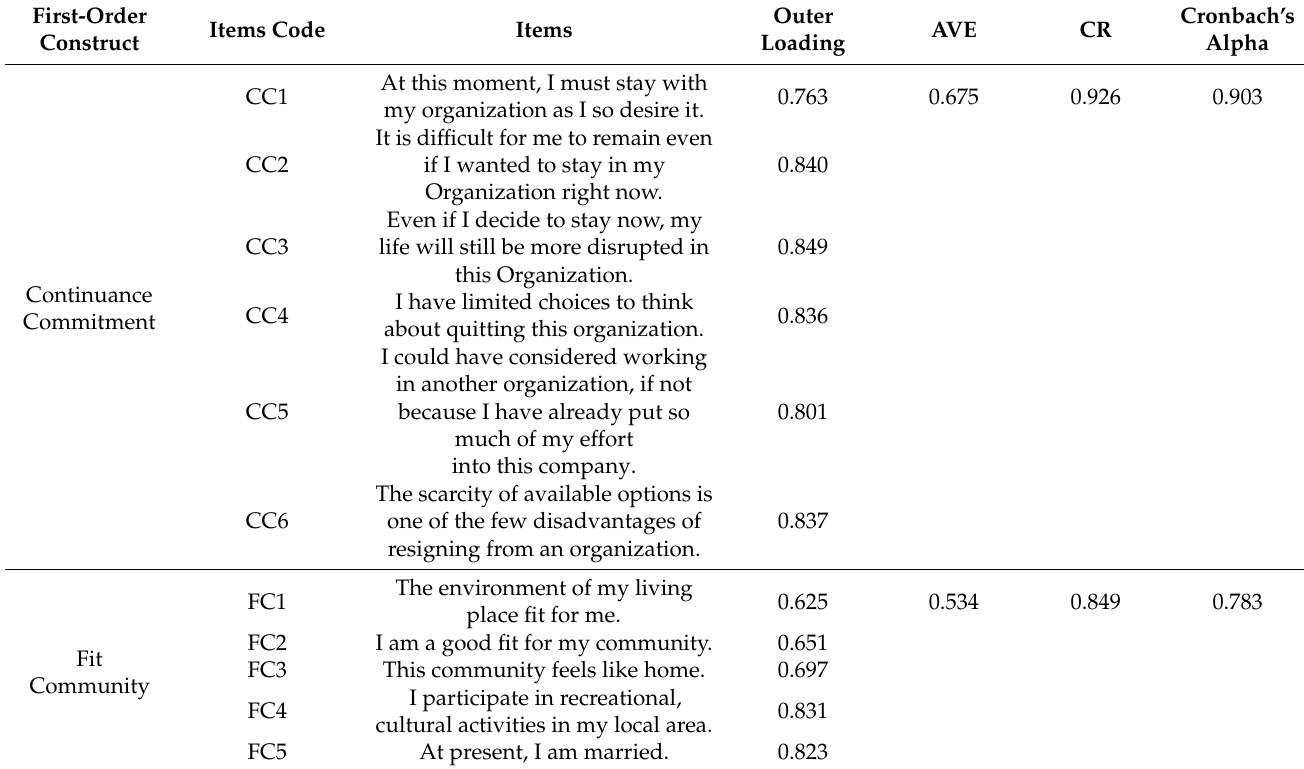
Figure 2. Partial Least Squares-Path Model. Table 2. Construct Reliability and